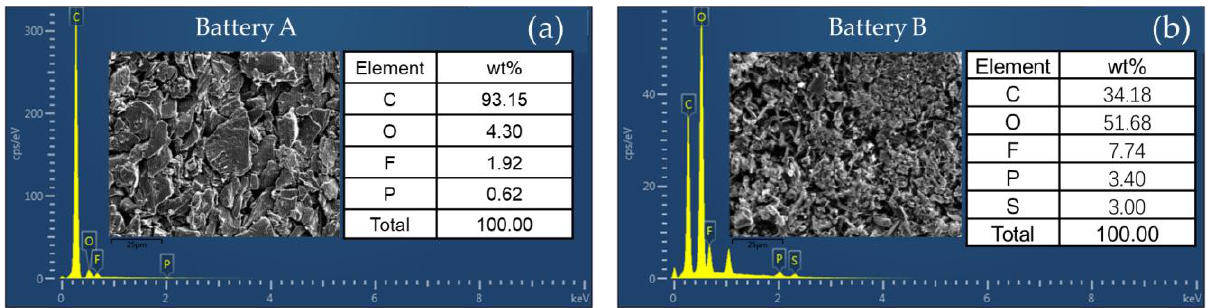
Figure 8. The SEM images of the negative electrode: ( a1-a3 ) Battery A; ( b1-b3 ) Battery B.